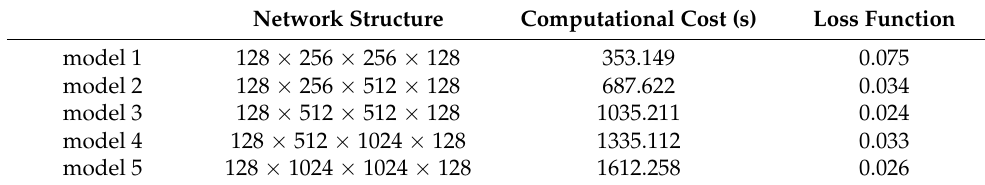
Table 4. Test results of different neural nodes.